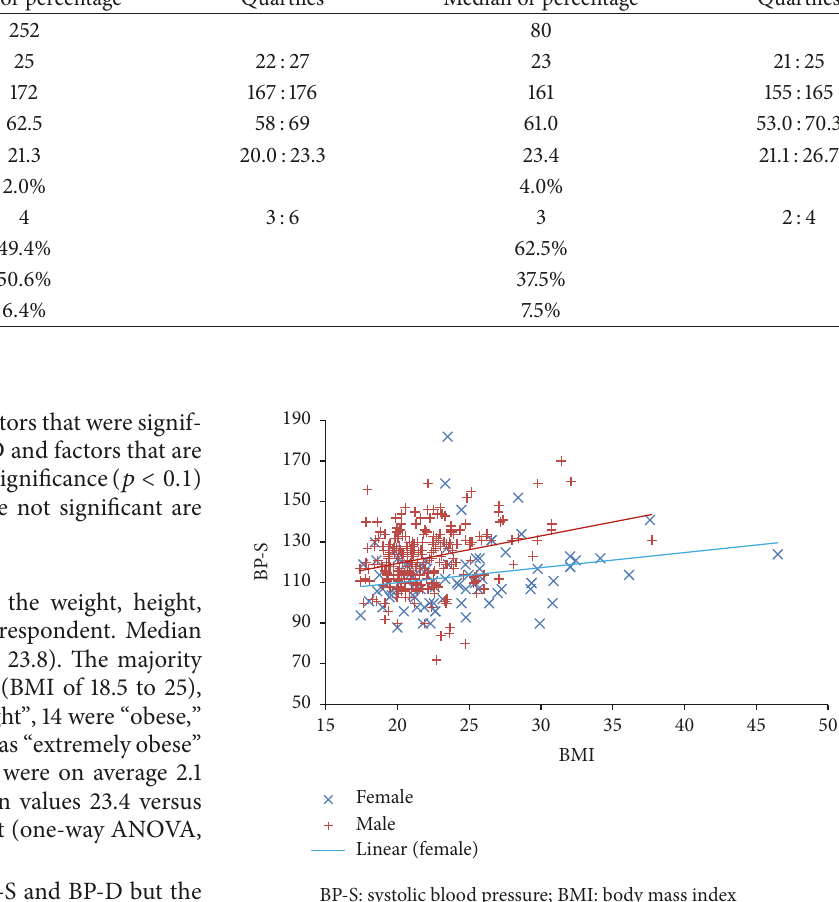
Figure 1: Systolic blood pressure (BP-S) and BMI for men and women.